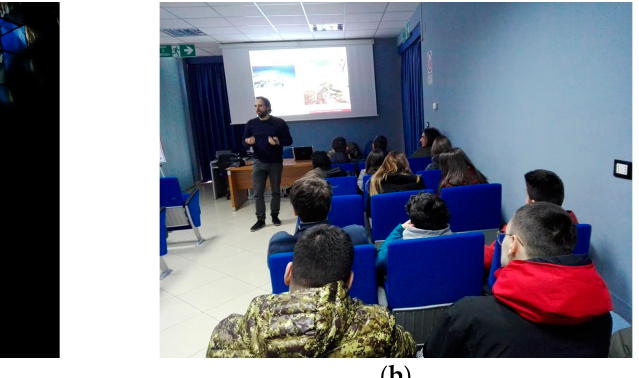
Figure 8. Methane emissions and gypsum deposits: ( a ) mud volcanoes at the Bolle della Malvizza in Montecalvo Irpino (AV); ( b ) the gypsum of Savignano Irpino quarries (AV).